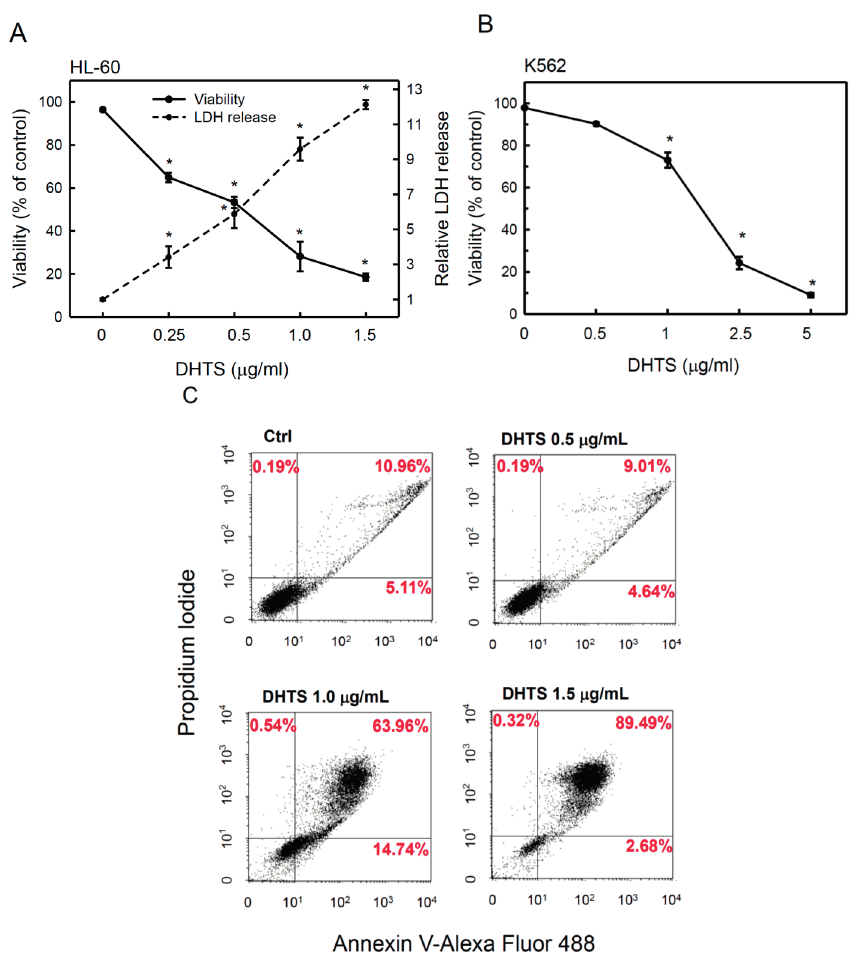
Figure 1. Effects of 15,16-dihydrotanshinone I (DHTS) on the cell viability and cytotoxicity of human HL-60 and K562 leukemia cells. ( A ) HL-60 cells were treated with various concentrations of DHTS for 24 h. Cell numbers and cytotoxicity were measured by counting viable cells using an MTT assay and lactate dehydrogenase (LDH) release, respectively; ( B ) K562 cells were treated with various concentrations of DHTS for 24 h. Cell numbers was measured by counting viable cells using an MTT assay; and ( C ) Cells were treated with various concentrations of DHTS for 24 h, and apoptotic cells were determined by FACS using the Annexin V-Alexa Fluor488 Apoptosis Assay Kit. Data are expressed as the mean ± S.D. of three independent experiments. * p < 0.05, compared to the